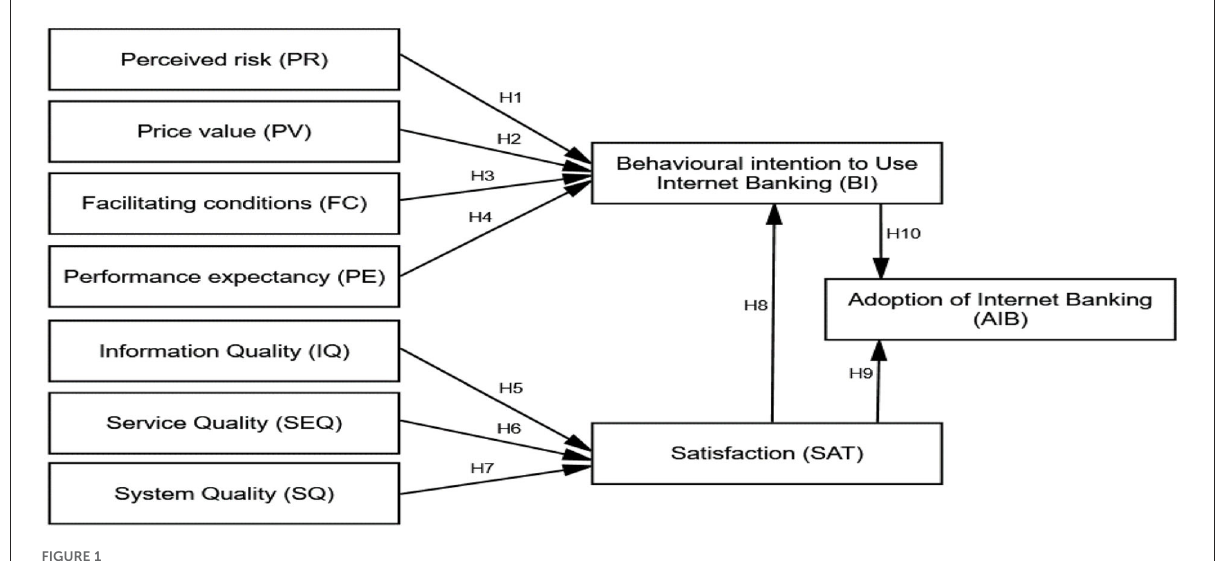
FIGURE1 The study